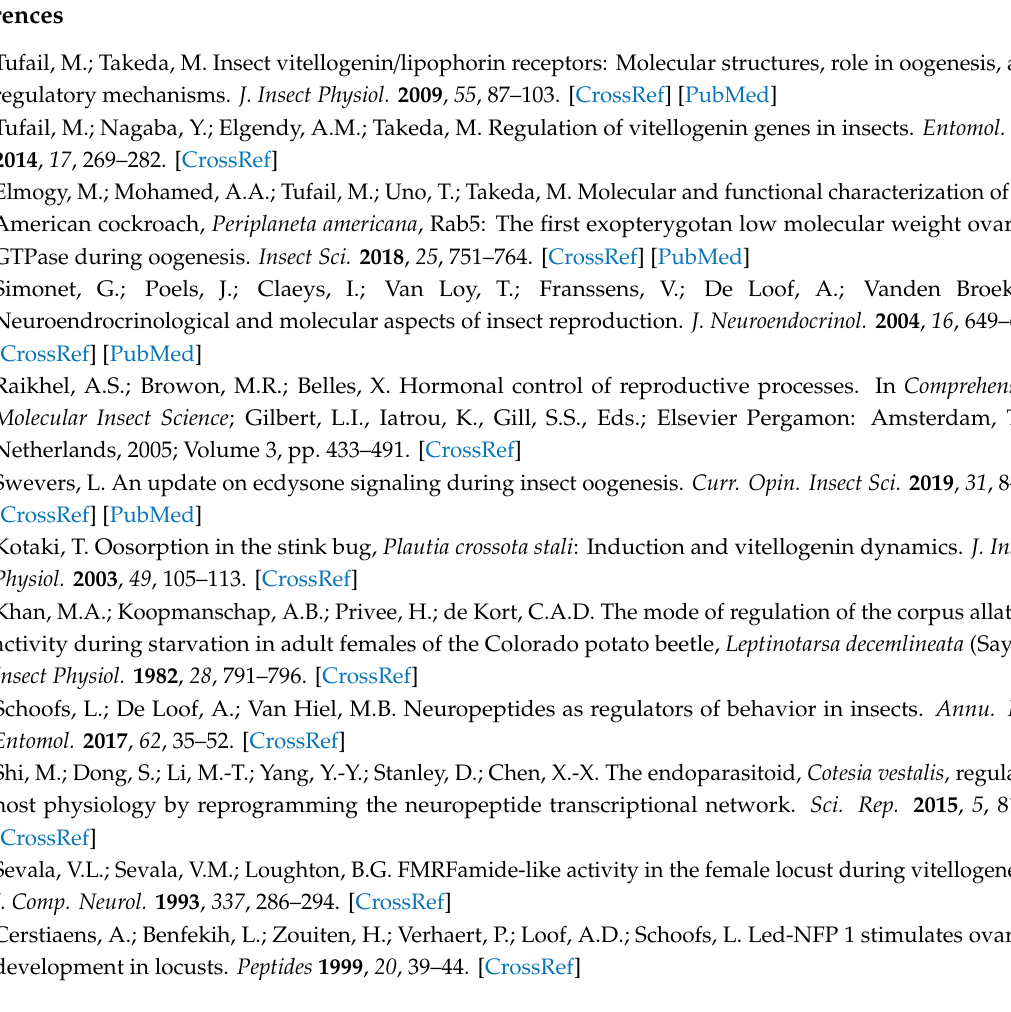
Figure S1: E ff ect of CCAP injection on ovarian ecdysteroid concentrations. Figure S2: E ff ect of sNPF injection on ecdysteroid concentrations in the